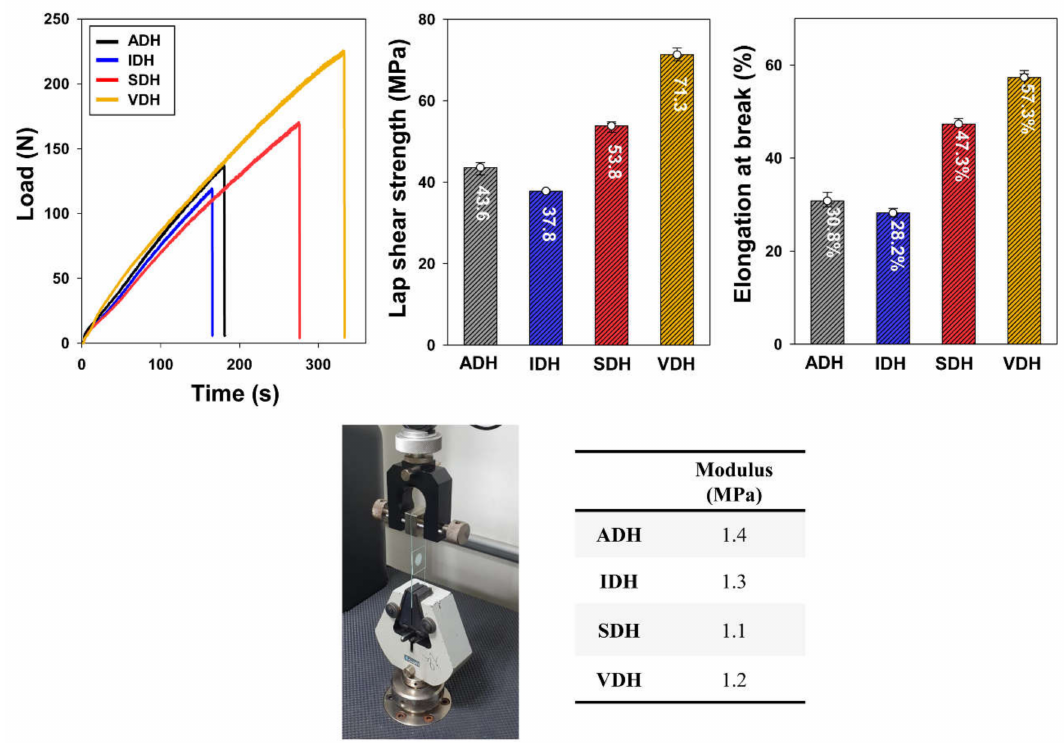
Figure 6. Results of lap shear test for various epoxy resin systems and their modulus